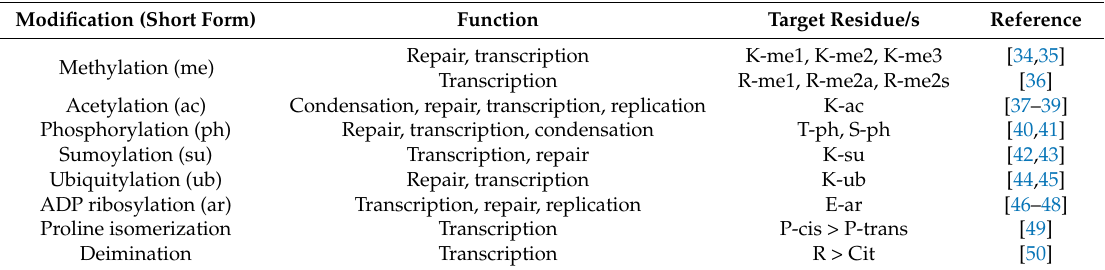
Table 1. Histone target(s) of various modifications and their associated functions.